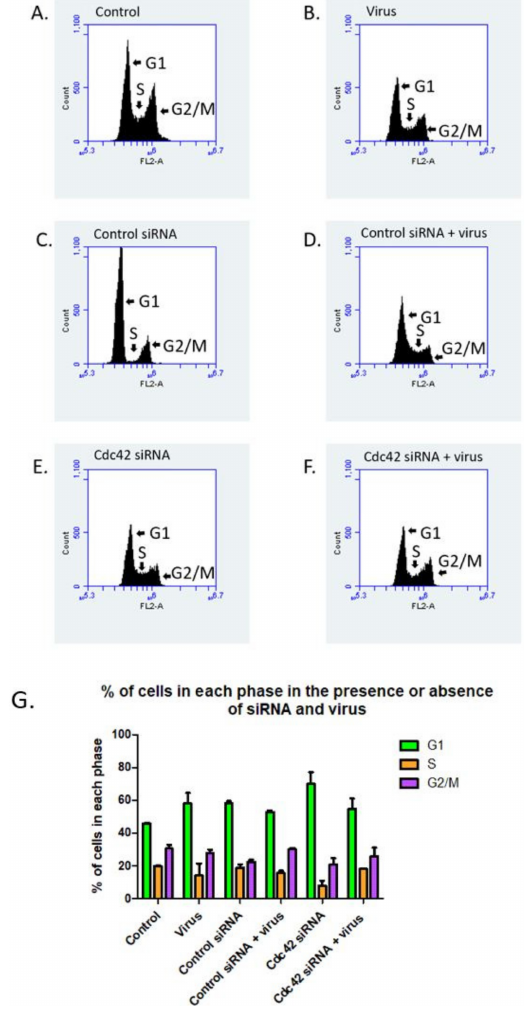
Figure 9. Cells treated with Cdc42 siRNA undergo cell cycle arrest in the presence and absence of virus. Histograms showing the percentage of cells in different stages of the cell cycle based on